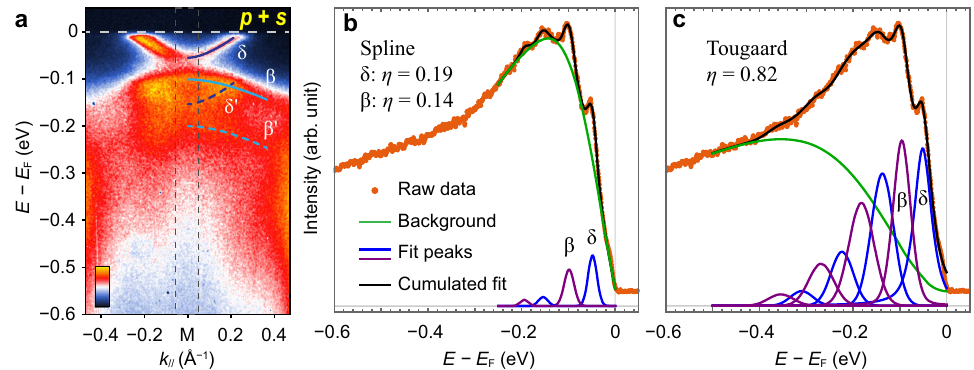
Fig. 4 Fitting ARPES results with mixed polarization. a Sum of the APRES maps around M point taken in p and s polarizations (Fig. 2a, d). b EDC integrated over the momentum range indicated by the dashed rectangle in a . The background is modeled using a cubic spline interpolation. The data are fi t to four Gaussian peaks, corresponding to δ and β bands and their replicas. c Same data as b , but fi t with a Tougaard background and two sets of multiple peaks for the δ and β bands, respectively.